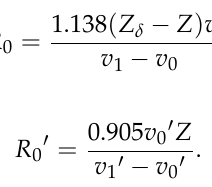
Figure 11. Effect of various factors on the longitudinal radius of the negative Gaussian curvature surface: ( a ) Maximum compression ratio; ( b ) Sheet width; ( c ) Sheet thickness; ( d ) Transverse curvature radius.